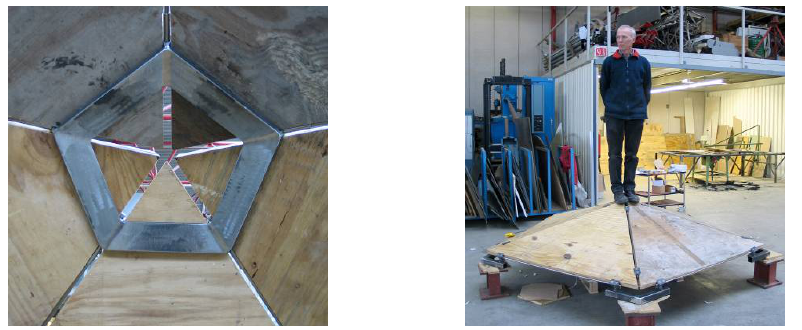
Figure 10: Pentagonal Mock-up of top of the dome in plywood (scale